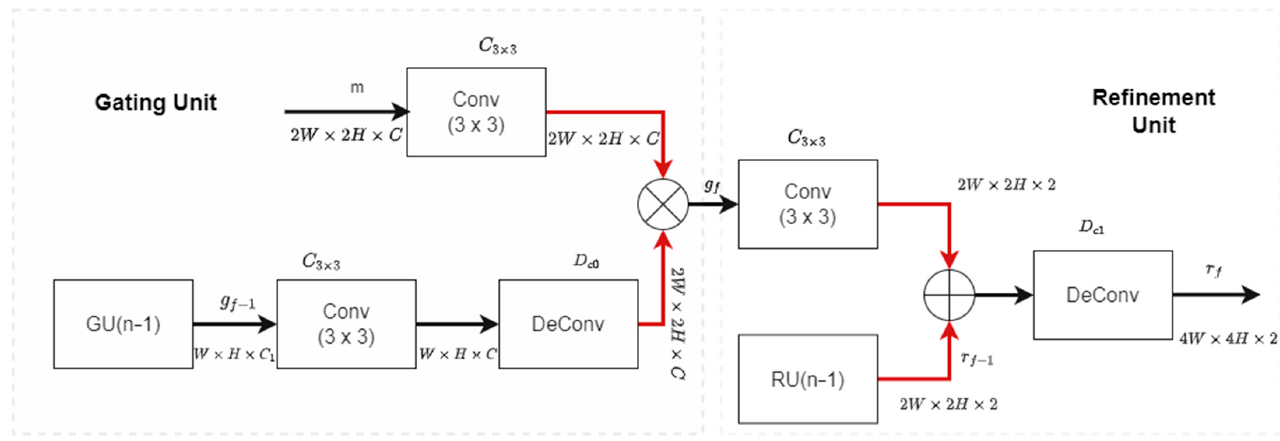
Figure 3. A schematic of the gated refinement unit architecture.